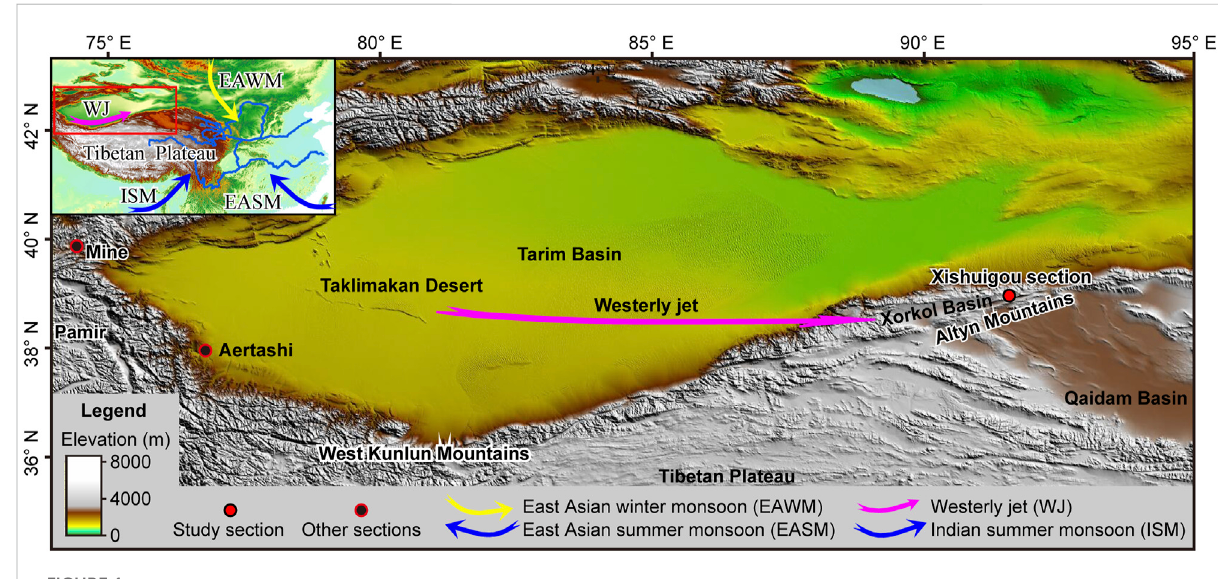
FIGURE 1 Geographic setting of the Altyn Mountains, Qaidam Basin, Tarim Basin, and surrounding mountains and deserts. The location of the Xishuigou section is shown with a red dot, and together with other sections (Kaya et al., 2019) mentioned in the text. Inset map shows modern Asian atmospheric circulation systems with the location of the Altyn Mountains, Qaidam Basin, and Tarim Basin in relation to the Tibetan